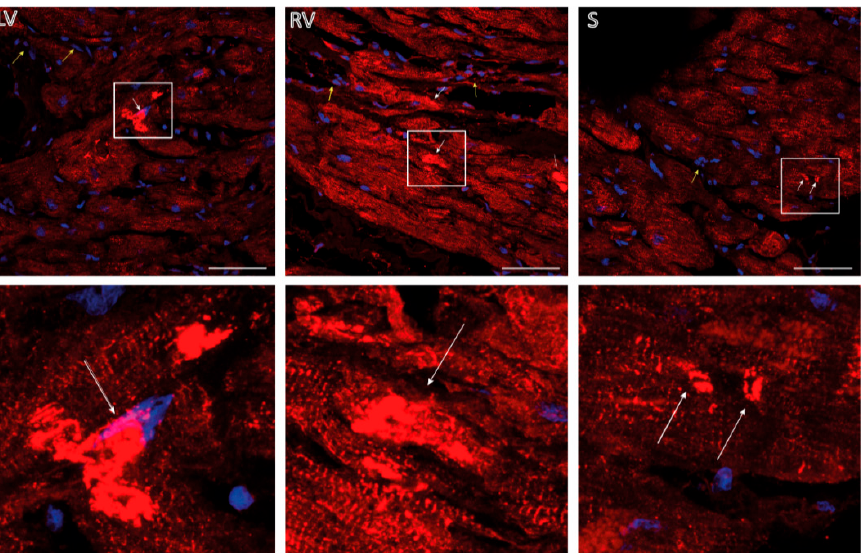
Figure 7. Immunohistochemistry analysis of explanted myocardial tissue from the index patient III-9. LV = left ventricular myocardial tissue; RV = right ventricular myocardial tissue; and S = septal myocardial tissue. Scale bars represent 50 µm. Desmin is shown in red. Nuclei were stained using DAPI and are shown in blue. Of note, desmin-positive aggregates were present in all three layers (white arrows). In addition, desmin-negative areas were present (yellow arrows) representing fibroblast or other non-cardiomyocyte cell types.